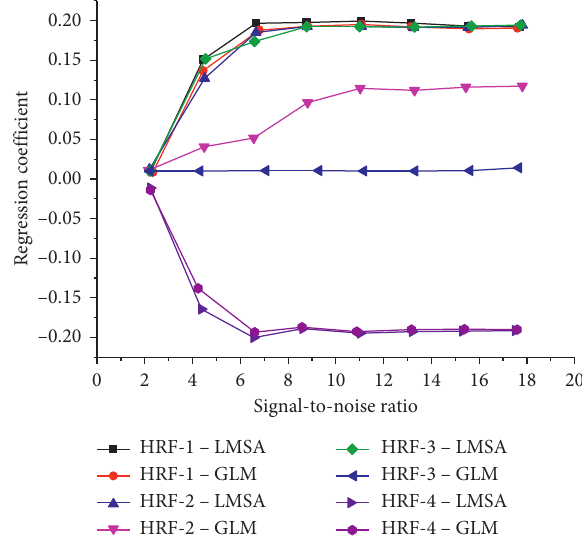
Figure 5: Simulation analysis results of LMSA and GLM under different signal-to-noise ratios.